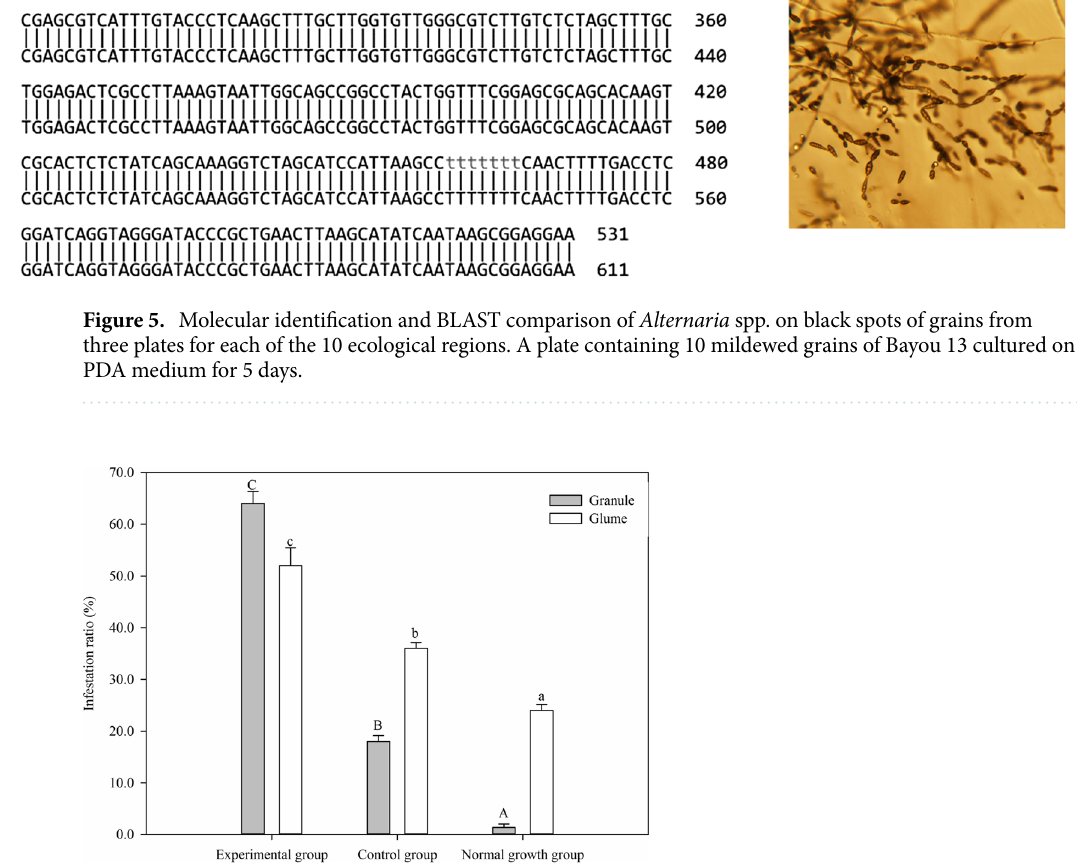
Figure 6. The comparison of infections by Alternaria spp. after 5 days of culture on PDA in the experimental group (2 weeks spraying with spore suspension of Alternaria ), control group (2 weeks spraying with water containing 0.1% Tween-20), and normal growth group (untreated) for either glumes or grains of Bayou 13 from Kelan County in Shanxi Province, China. The gray and white columns represent the means for granules and glumes, respectively, and the bars represent the SE. Different uppercase and lowercase letters above the columns indicate significant differences within the three groups (least significant difference test, P < 0.05) for granules and glumes,